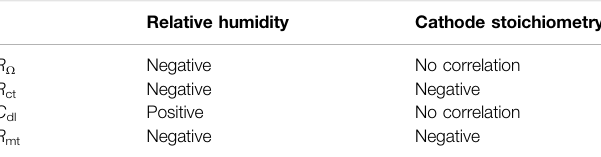
TABLE 3 | Summary of in fl uence on parameters for the various changes investigated in this